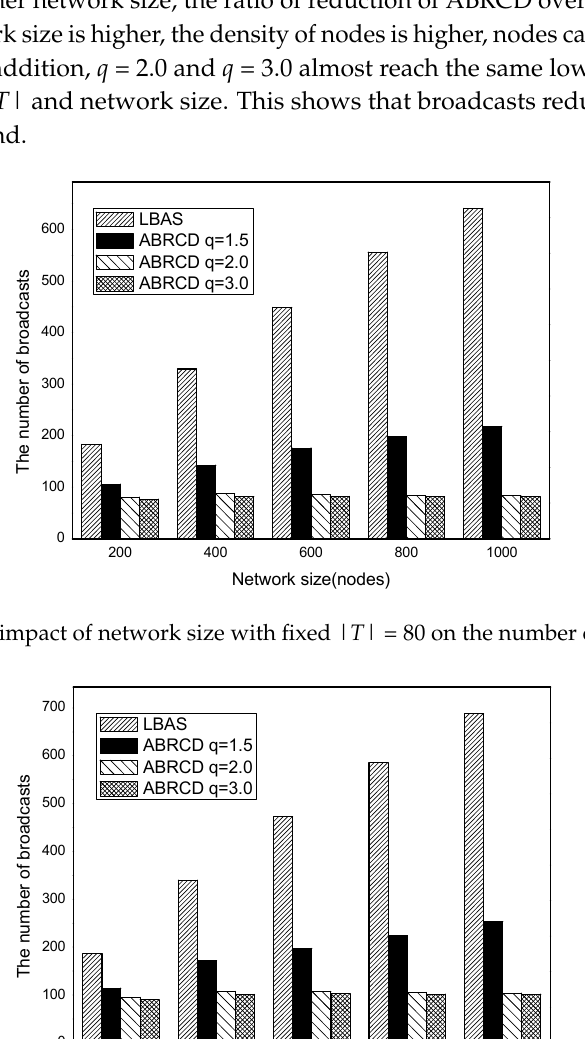
Figure 34. The impact of network size with fixed | T | = 60 on the number of broadcasts.